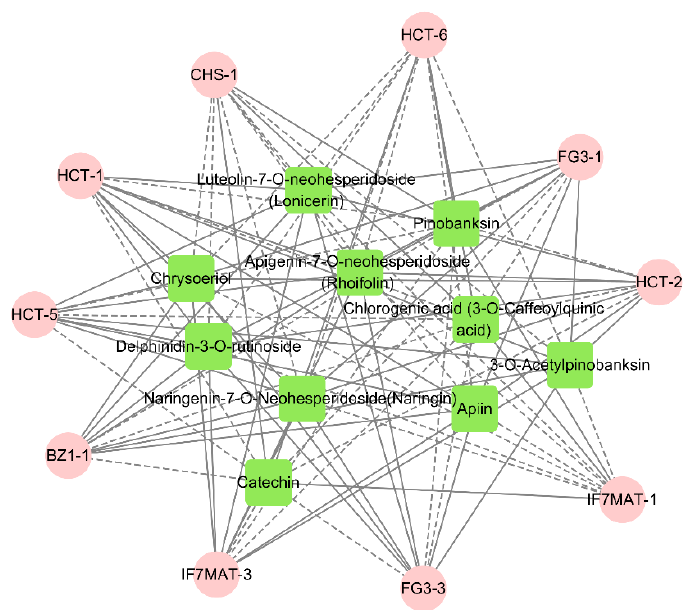
Figure 8. Metabolites and genes combined analysis network (pink represents genes; green represents metabolites. Solid lines represent positive correlations between metabolites and genes; dashed lines represent negative correlations between metabolites and genes. Shorter lines represent stronger correlations between metabolites and genes).